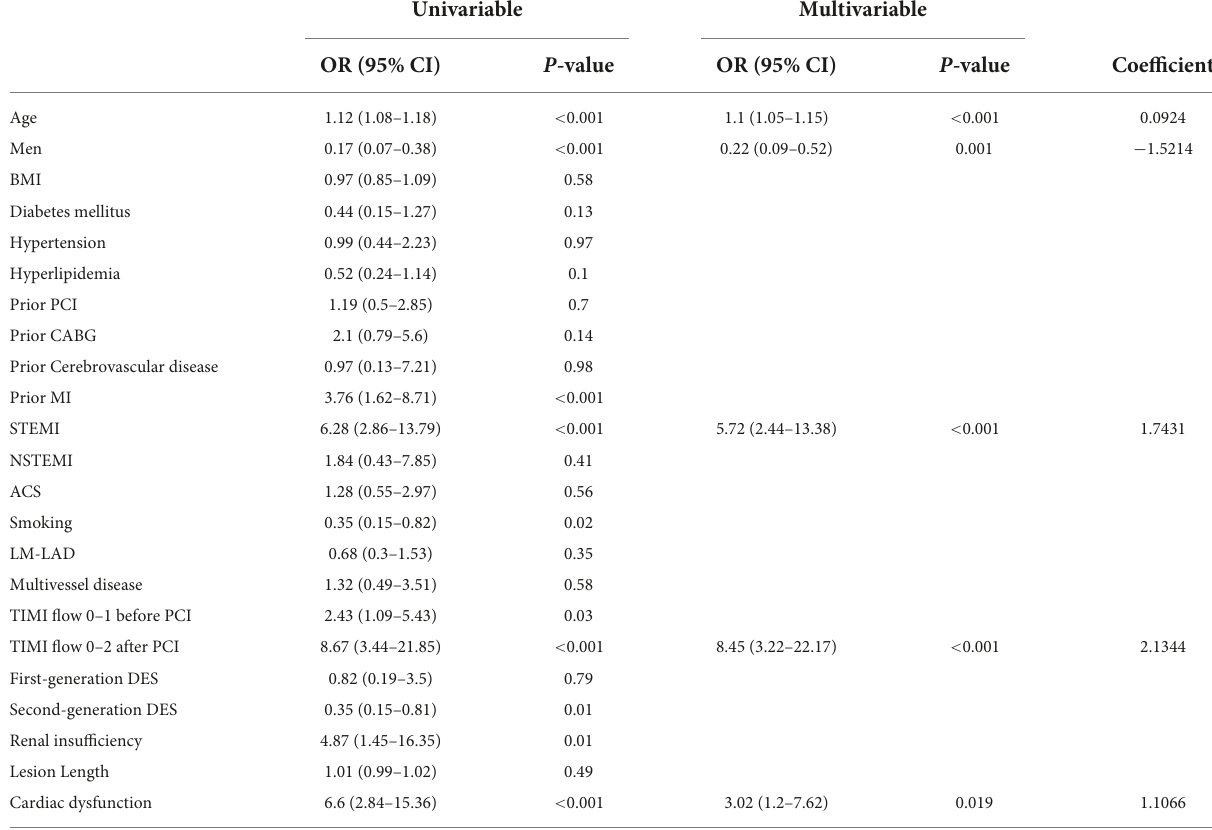
TABLE 2 Logistic regression model for 30-day